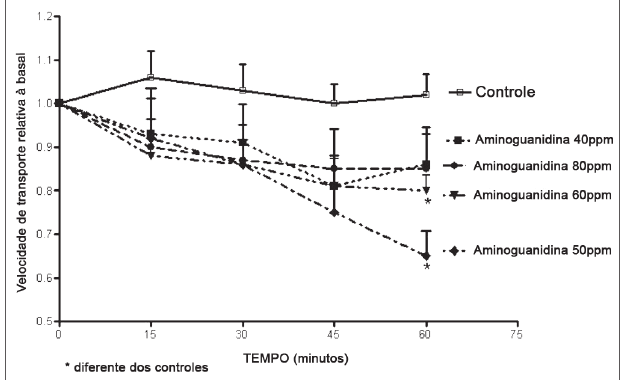
Figura 1. Velocidade relativa do transporte mucociliar em palatos de rã imersos em solução deRinger R (controles) ou em soluções 40 ppm, 50 ppm, 60 ppm ou 80 ppm de aminoguanidina.